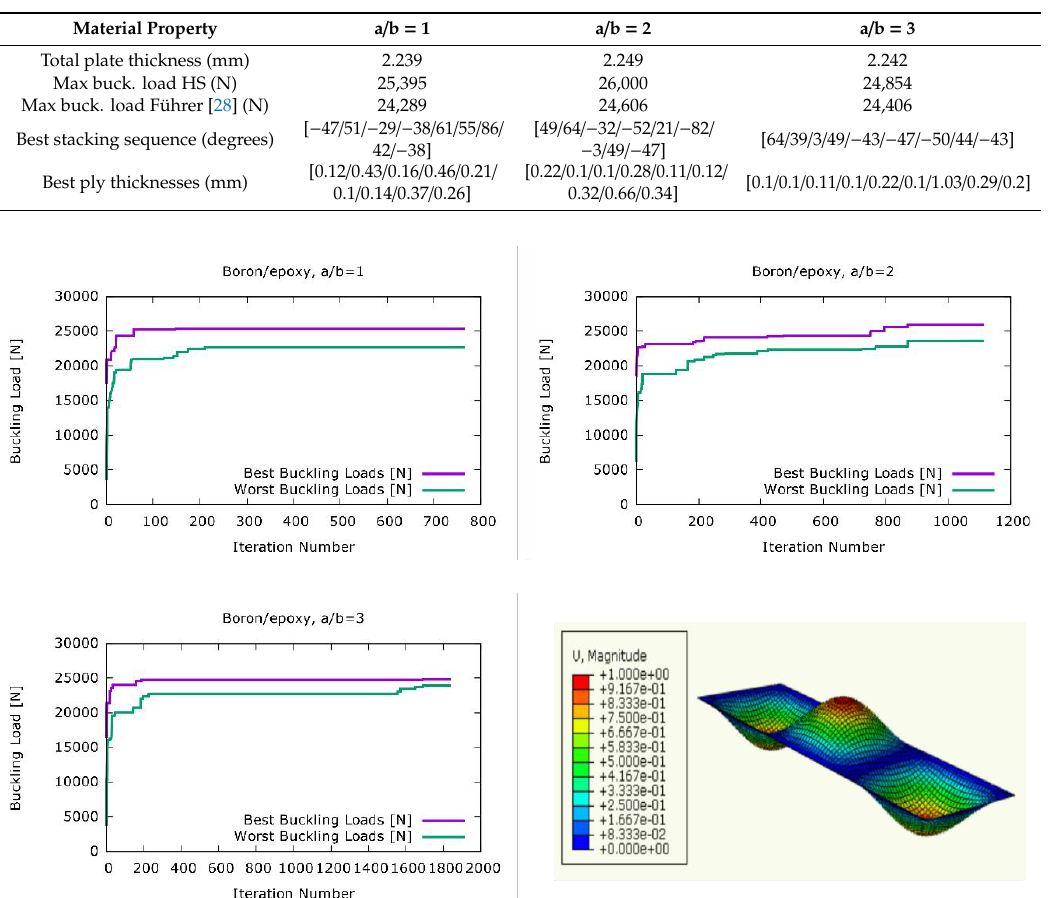
Figure 4. The development of the best and worst solutions in the harmony search optimisation for boron/epoxy plates.